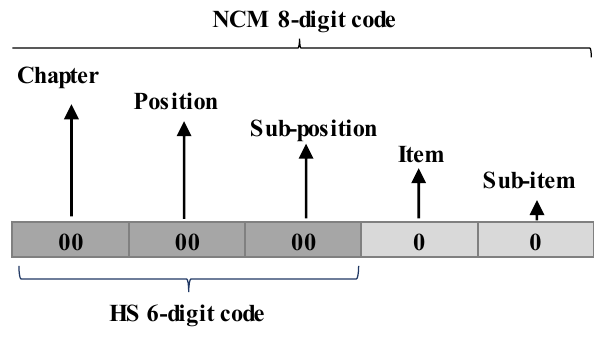
Figure 1. Composition of the NCM Code.